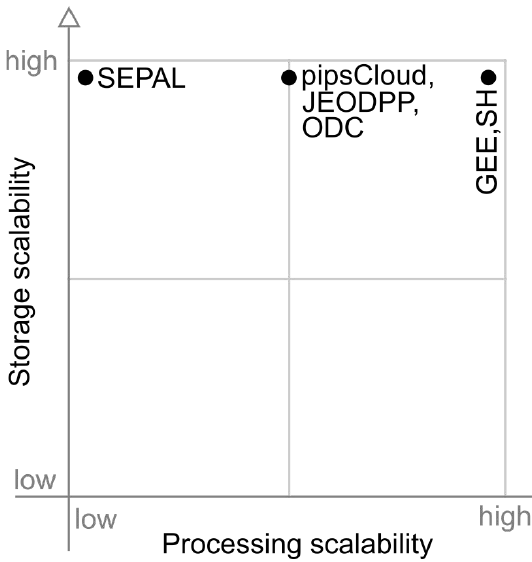
Figure 11. Processing scalability vs. Storage scalability.